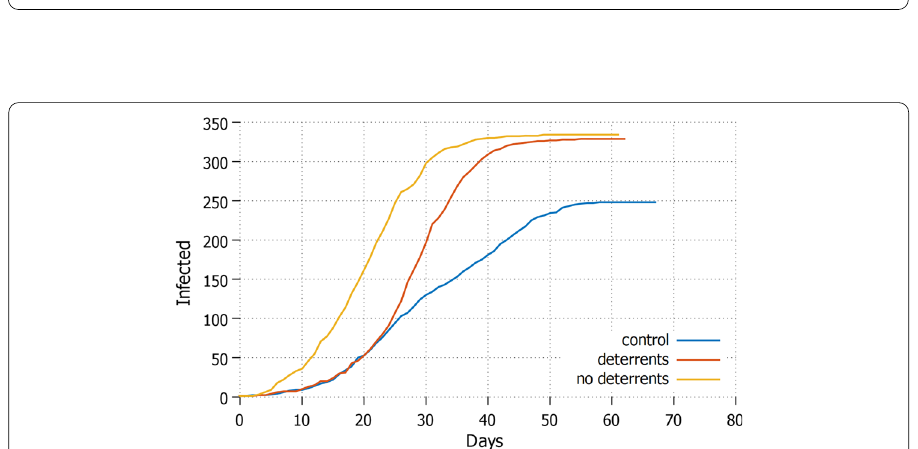
Fig. 6 Retired Daily increment with retired people in lockdown and protective measures